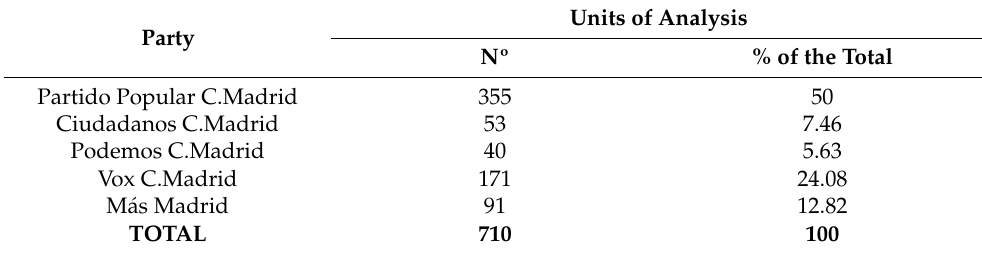
Table 1. Distribution of the sample. Units of Analysis Party Nº % of the Total Partido Popular C.Madrid 355